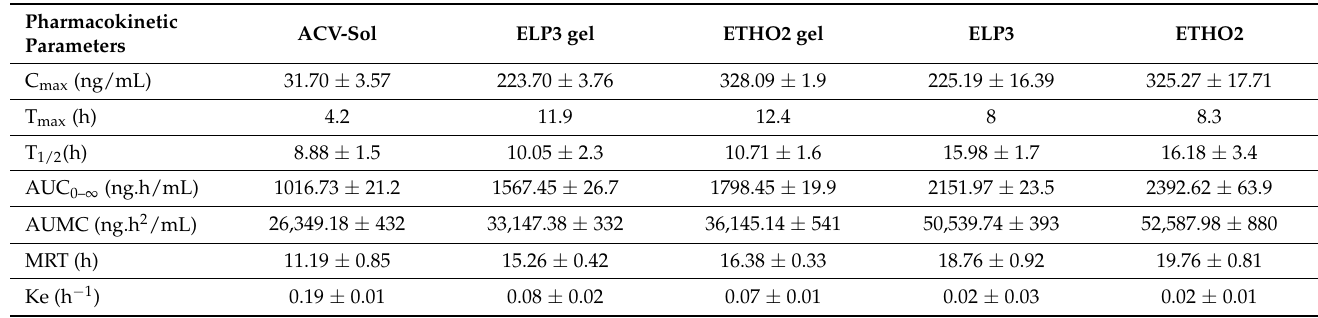
Table 9. Summary of pharmacokinetic data for various formulations.